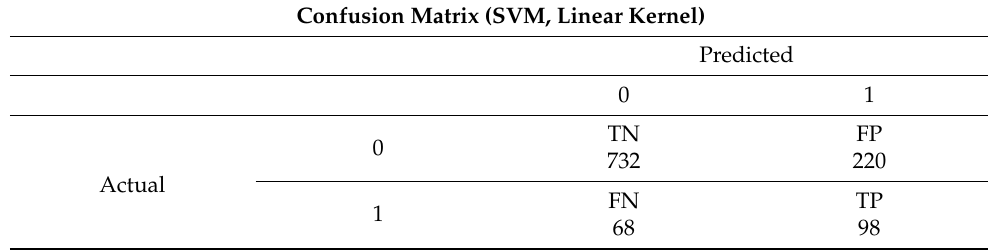
Table 4. Confusion matrix of SVM Model with linear